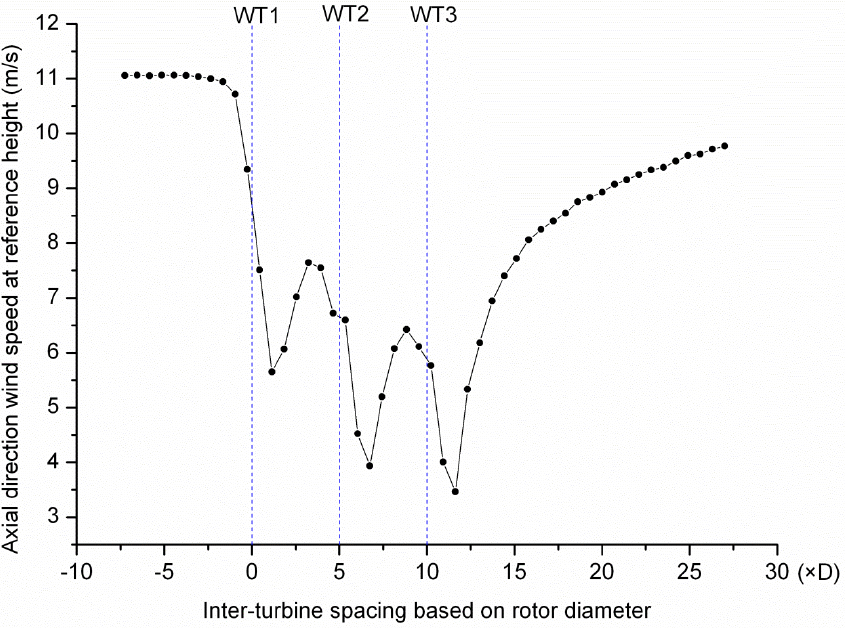
Figure 7. Axial direction wind speed profile along the center line at the reference height in case 3 (L2 =